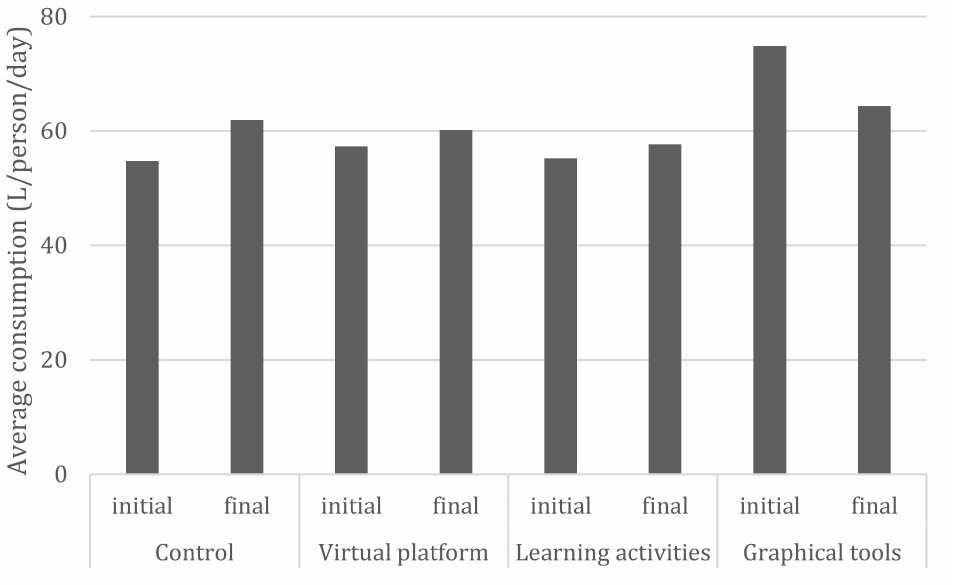
Figure 4. Comparison of initial and final consumptions for each intervention